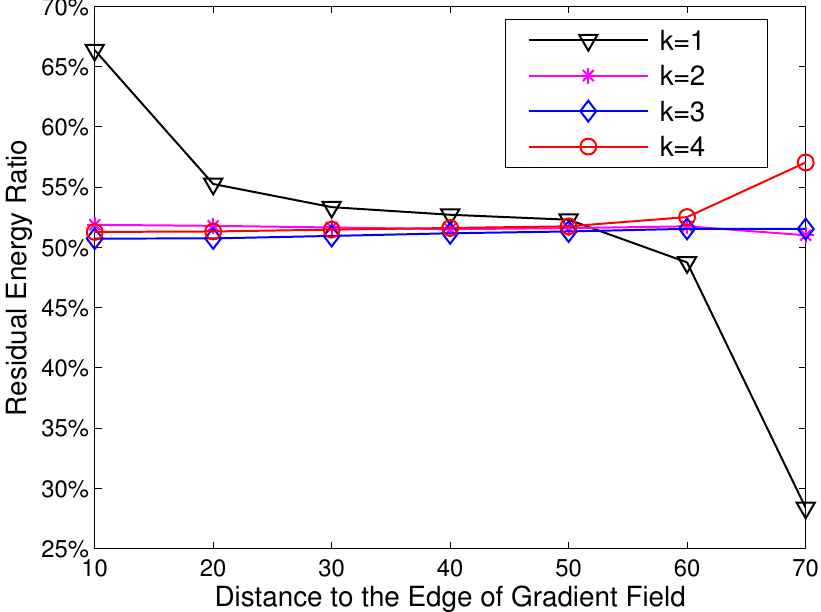
Figure 2. The residual energy ratio with different node